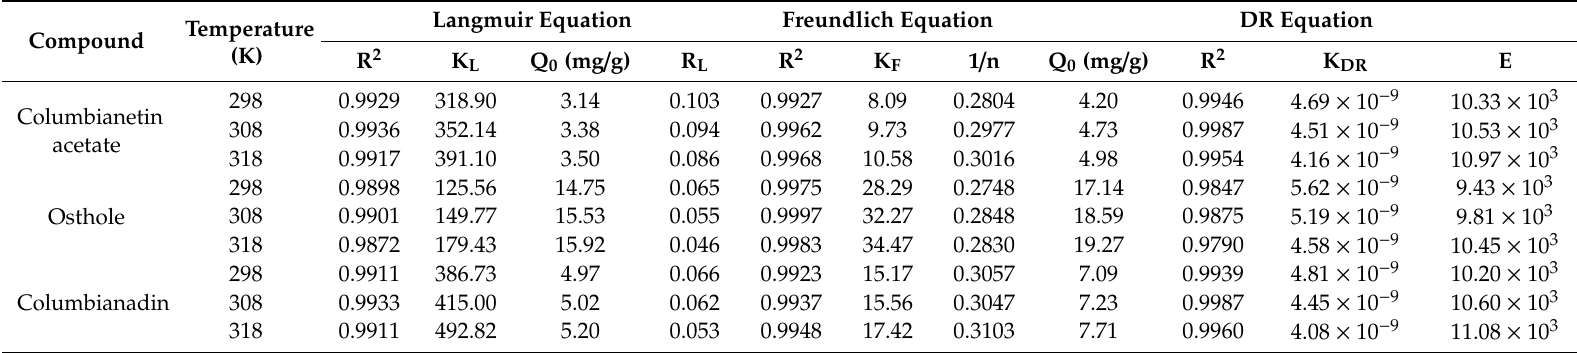
Table 3. Langmuir, Freundlich and Dubinin Radushkevich (DR) parameters for three coumarins on HP-20 resin at di ff erent temperature.